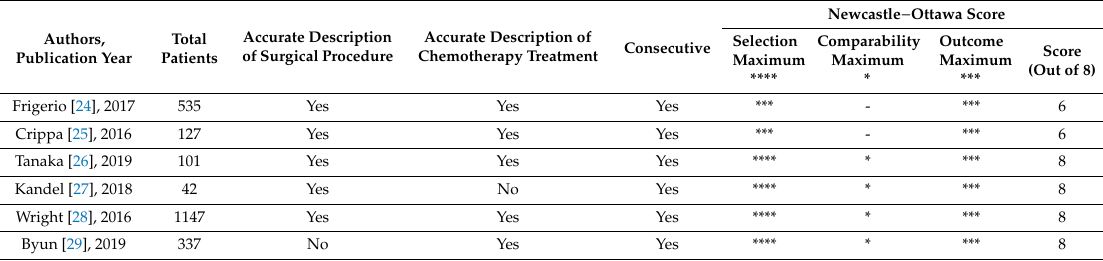
Table 2. Level of evidence and quality assessment of the selected